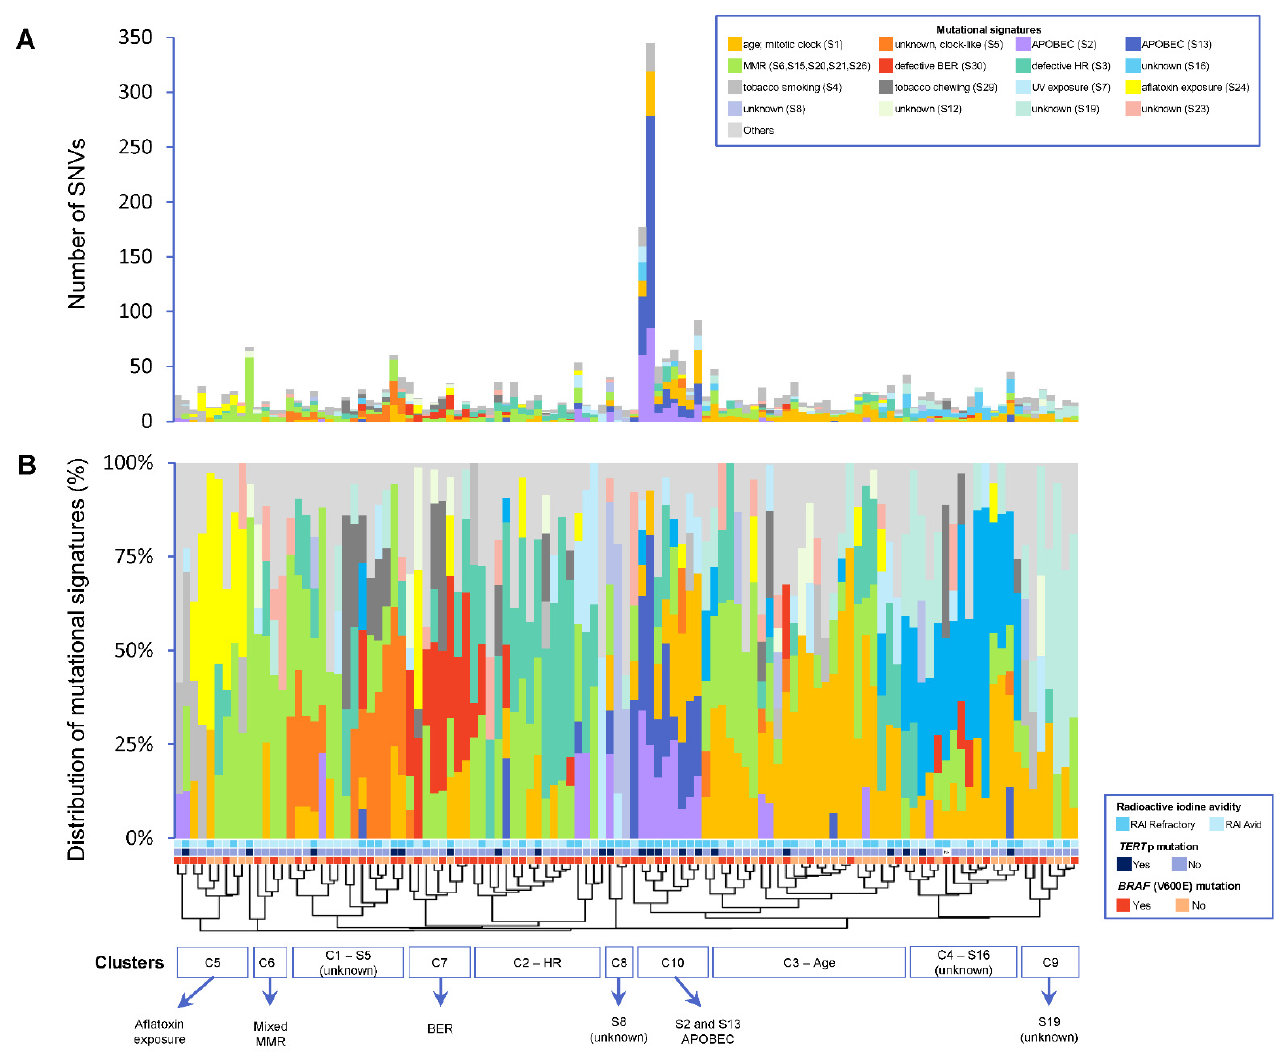
Figure 2. ( A ) Overview of absolute number of mutations contributing to each mutational signature per sample. ( B ) Distribution of each mutational signature per sample. Patients are ordered by hier- archical clustering. An alpha level of 0.05 was used for statistical significance. S1 represents age-related mutations; S2 and S13 represent APOBEC-related mutagenesis; S6, S15, S20, S21 and S26 represent defective DNA mismatch-repair (MMR) mutations; S3 represents defective homologous recombination-related DNA repair (HR); S30 represents defective base-nucleotide excision repair (BER); S4 represents tobacco smoking; S7 represents ultraviolet (UV) exposure; S24 represents afla- toxin exposure; S29 represents chewing tobacco; and S5, S8, S12, S16, S19 and S23 are of unknown etiology.